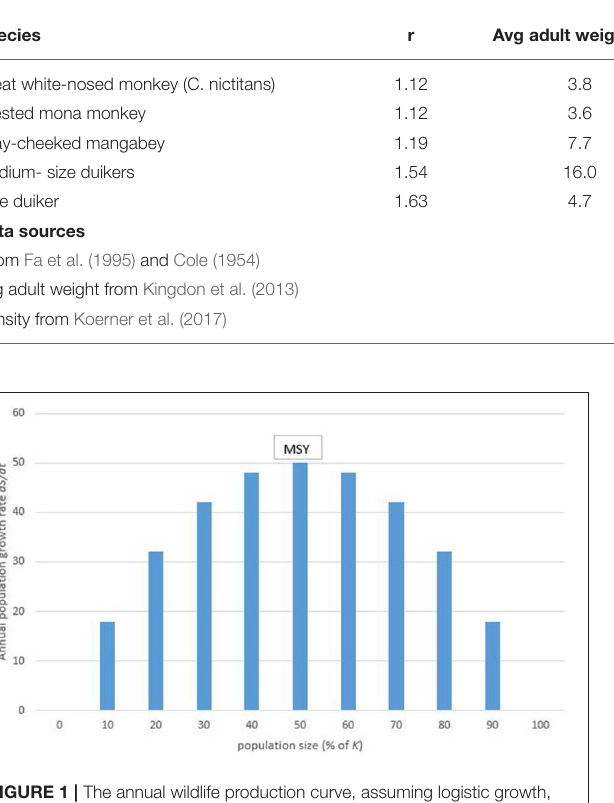
and are not advocating this as a hunting management